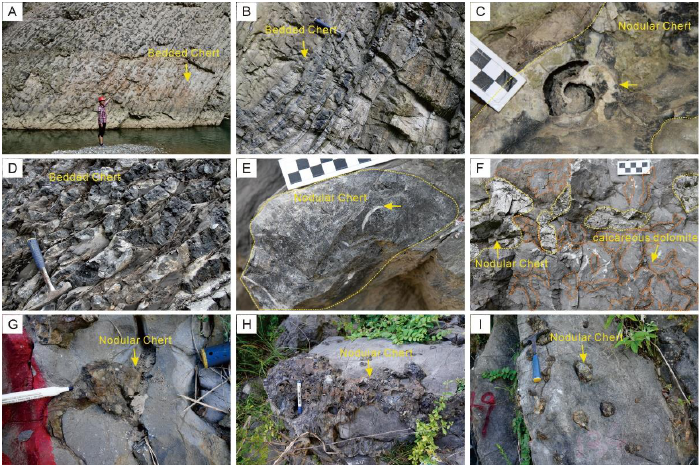
Figure 3. Photos of different outcrops showing bedded and nodular cherts of the Maokou Formation. ( A ) Bedded cherts at SH section; ( B ) bedded cherts at SH section; ( C ) nodular chert (length = 12 cm; height = 3 cm) is wrapped by host limestones at MEY section. A gastropod fragment is well preserved; ( D ) bedded cherts are interbedded with the argillaceous limestone at EY section; ( E ) nodular chert (L = 18 cm; H = 9 cm) is wrapped by limestone at LSX section. A calcareous brachiopod fragment is preserved; ( F ) nodular chert and calcareous dolomite are wrapped by host micrite limestone, MEY section; ( G – I ) nodular cherts show different sizes in the thick micrite–bioclastic limestone at the MEY section.